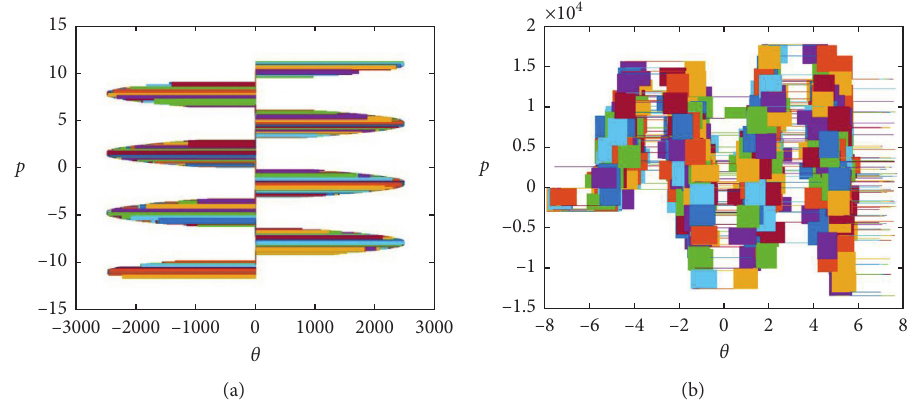
Figure 2: Model of underdetermined transmission: (a) L � 0 . 05 and K � 0 . 01; (b) L � 0 . 03 and K � 0 .